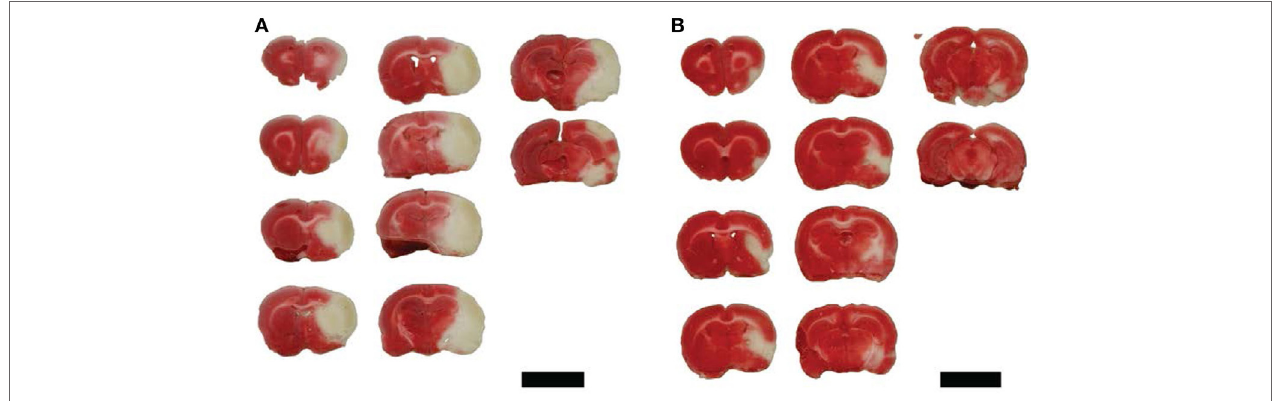
FigUre 4 | Representative tetrazolium chloride sections demonstrated infarct volume with PBS control treatment and hydrophilic carbon cluster, conjugated to poly(ethylene glycol) (PEG-HCC) treatment following 90-min ischemia and reperfusion. (a) PBS control demonstrating entire MCA territory infarction. (B) Following treatment with PEG-HCCs and demonstrated considerable cortical sparing. Tissue section groups came from individual rats. Scale bars are 1 cm.